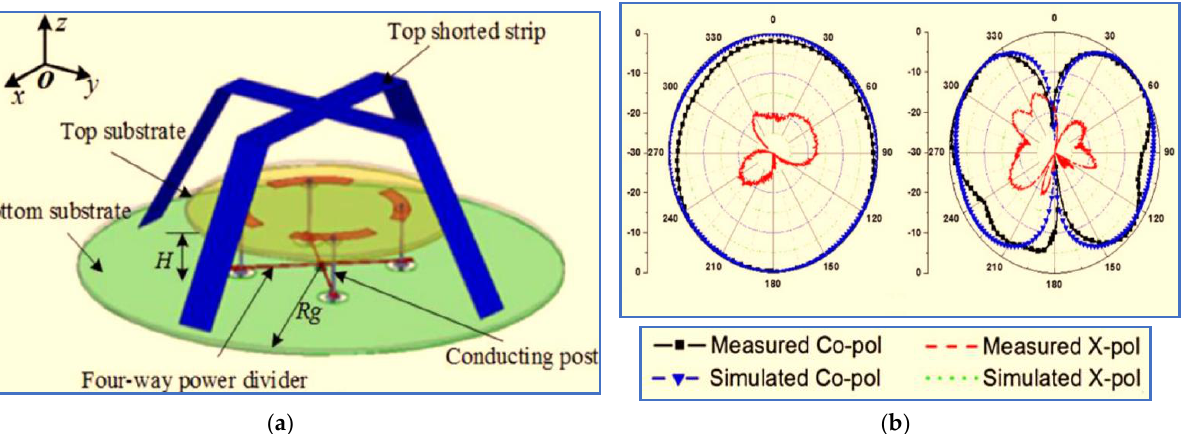
Figure 4. Overview of the proposed indoor antenna: ( a ) geometry and ( b ) radiation pattern at 2.0 GHz [47].